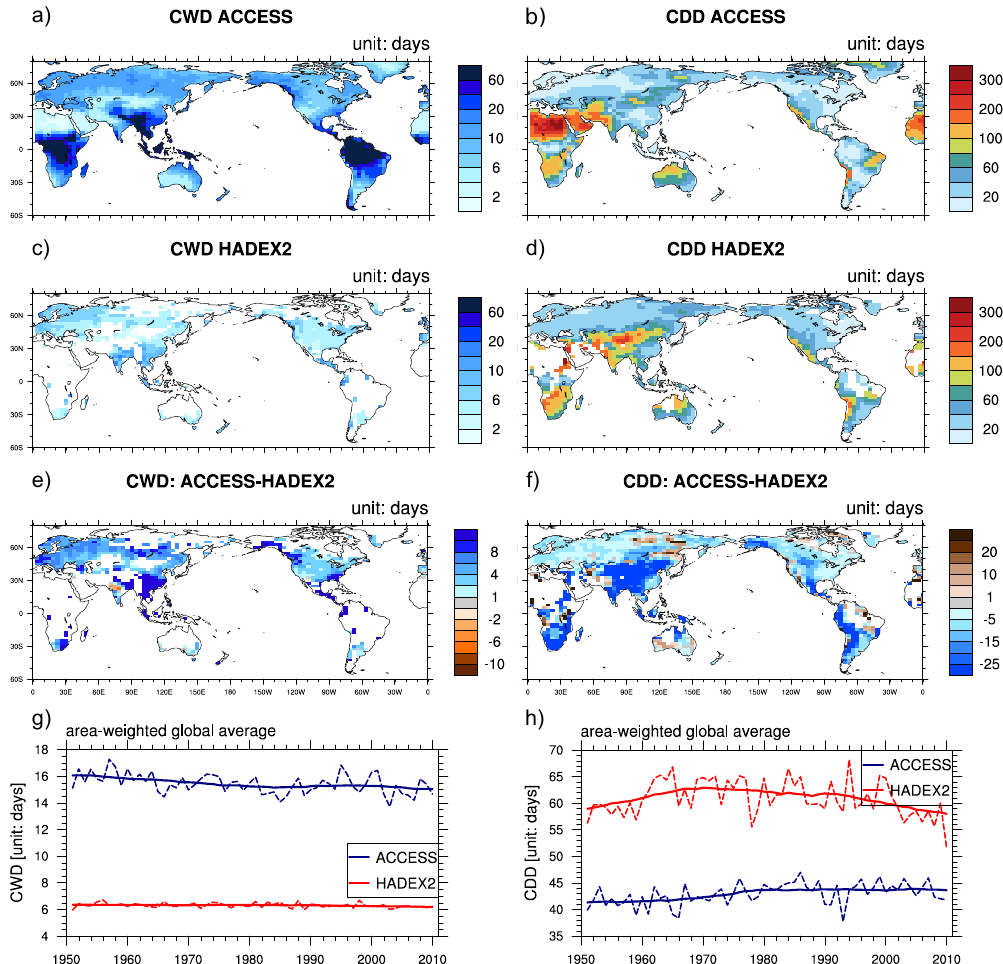
Fig. 8. Annual consecutive wet days (CWD, left column) and consecutive dry days (CDD, right column) for ACCESS1.3b (a, b) , HadEX2 (c, d) , bias (e, f) and the global average time series showing trends (g, h) . Unshaded areas reflect missing observation data. We applied a static masked only including grid points where more than 50 years of data (out of 60) were available to calculate the global average. The solid lines in (g) and (h) show the time series smoothed by a 21-year Gaussian filer, while the dashed lines show the yearly